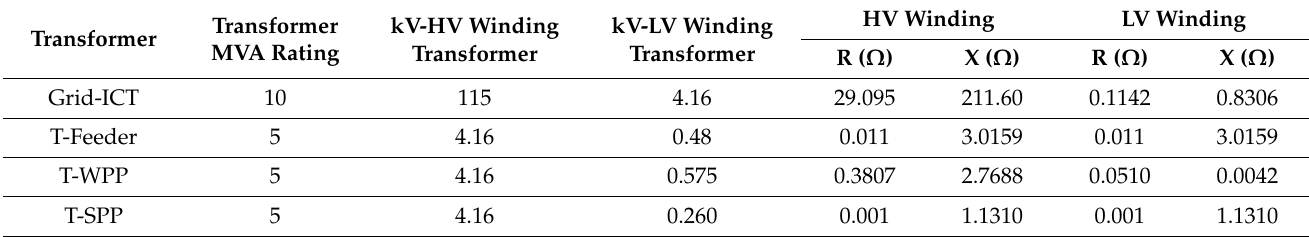
Figure 1. Remotely located distribution grid.